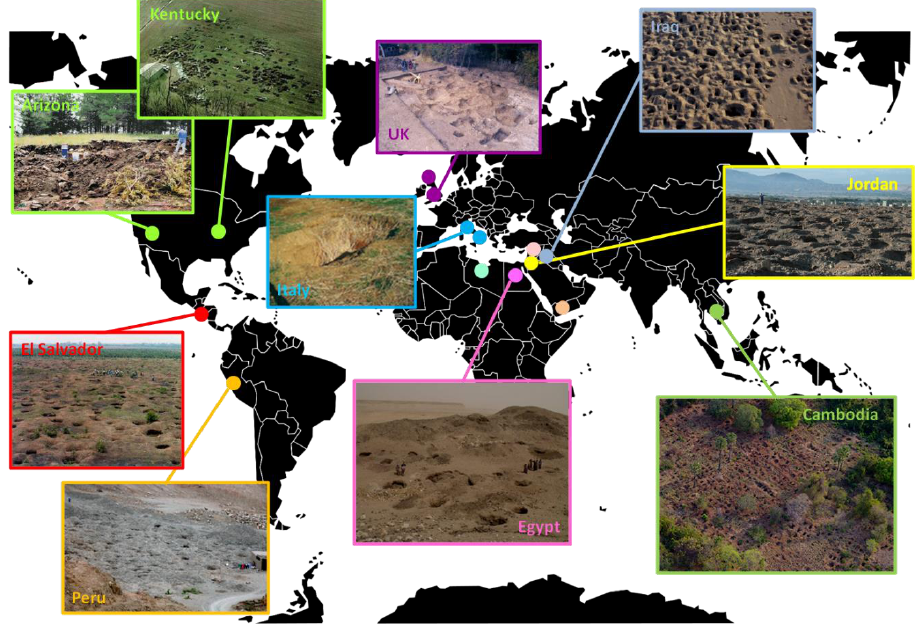
Figure 1. Graphic representation of the widespread phenomenon of looting in archaeological heritage sites and cultural landscapes across the globe. The map is not exhaustive and intentionally provides a sample for demonstration purposes only.